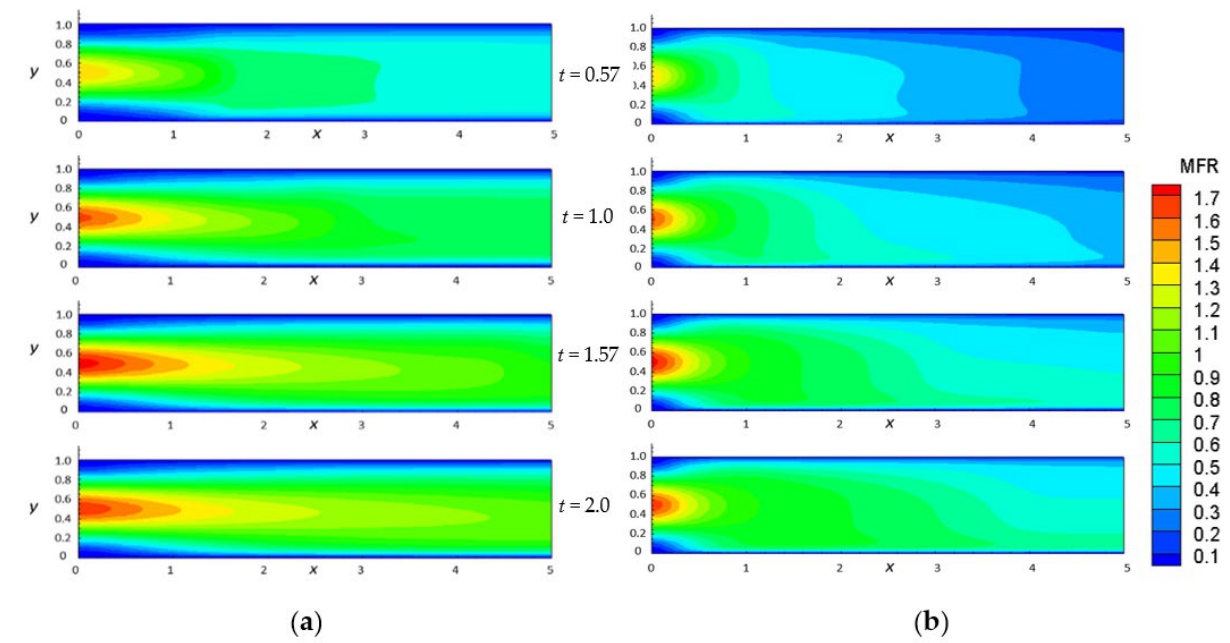
Figure 4. Time evolution of mass flow rate at dimensionless times 0.57, 1.0, 1.57 and 2.0 for a Stuart number of ( a ) N = 0 ( b ) N = 10.